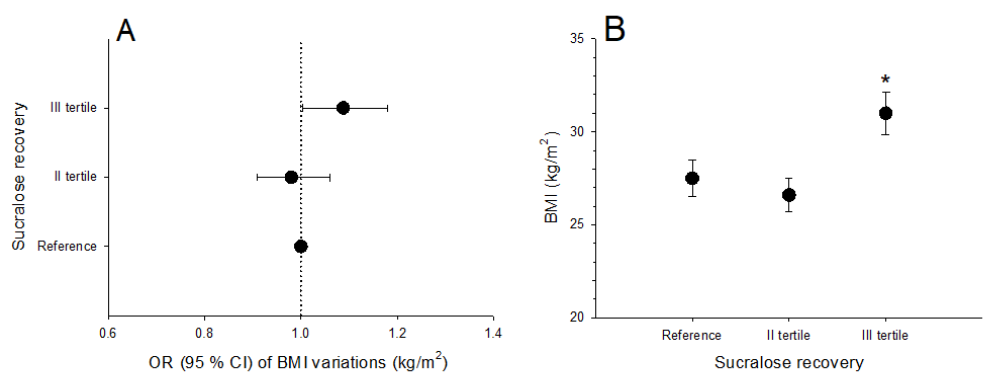
Figure 6. Correlation between sucralose recovery and waist, neck, and hip circumferences in: All subjects ( A ) and in females ( B